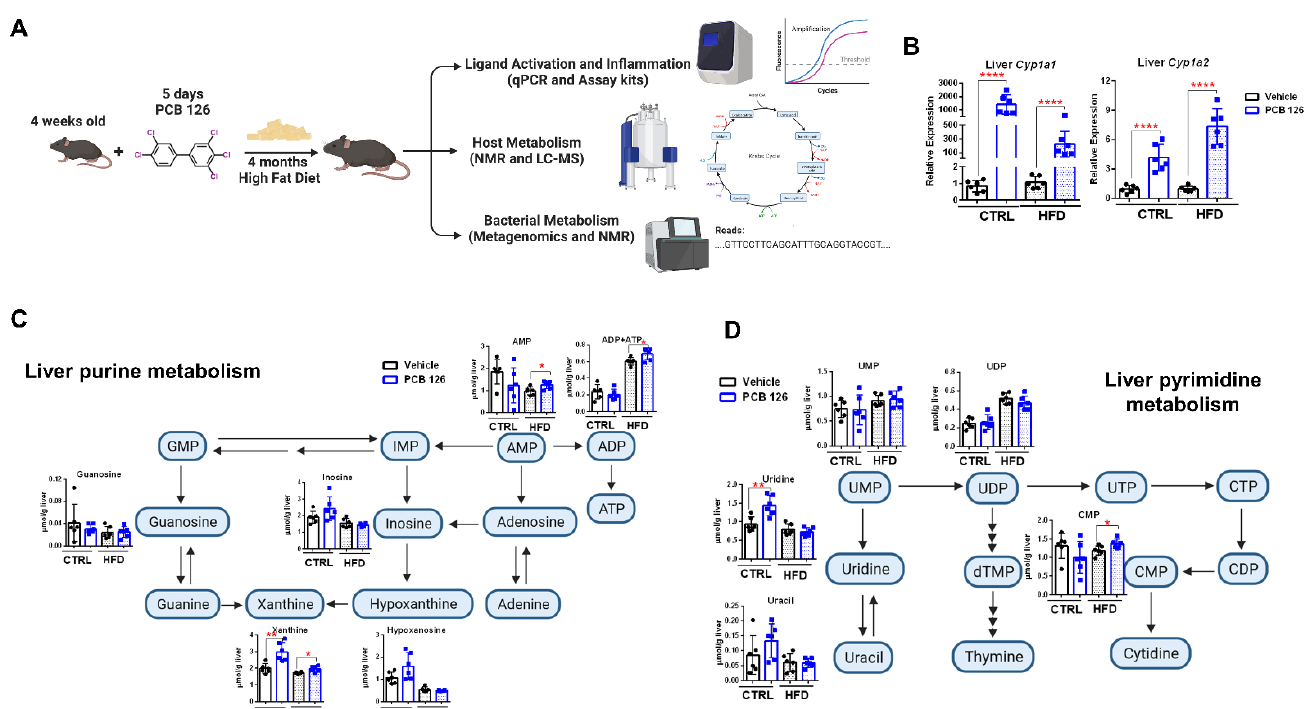
Figure 1. Effects of early life PCB 126 on AHR signaling and liver nucleotide metabolism in mice with CTRL or HFD. ( A ) Experimental schematic for determining the interaction between diet and early life PCB 126 exposure. ( B ) qPCR analysis of mRNA levels of AHR targeted genes in the liver from CTRL or HFD-fed mice with vehicle or PCB 126 exposure. ( C , D ) 1 H NMR analysis of liver purines ( C ) and pyrimidines ( D ) from CTRL or HFD-fed mice with vehicle or PCB 126 exposure. Values are means ± S.D. (n = 6 per group). * p < 0.05, ** p < 0.01, **** p < 0.0001 compared to vehicle. AMP, adenosine monophosphate; ADP, adenosine diphosphate; ATP, adenosine triphosphate; CDP, cytidine 5 ′‐ diphosphate; CMP, cytidine 5 ′‐ monophosphate; CTP, cytidine 5 ′‐ triphosphate; GMP, guanosine monophosphate; IMP, inosine monophosphate; UMP, uridine monophosphate; UDP, uridine 5 ′‐ diphosphate; UTP, uridine 5 ′‐ triphosphate.